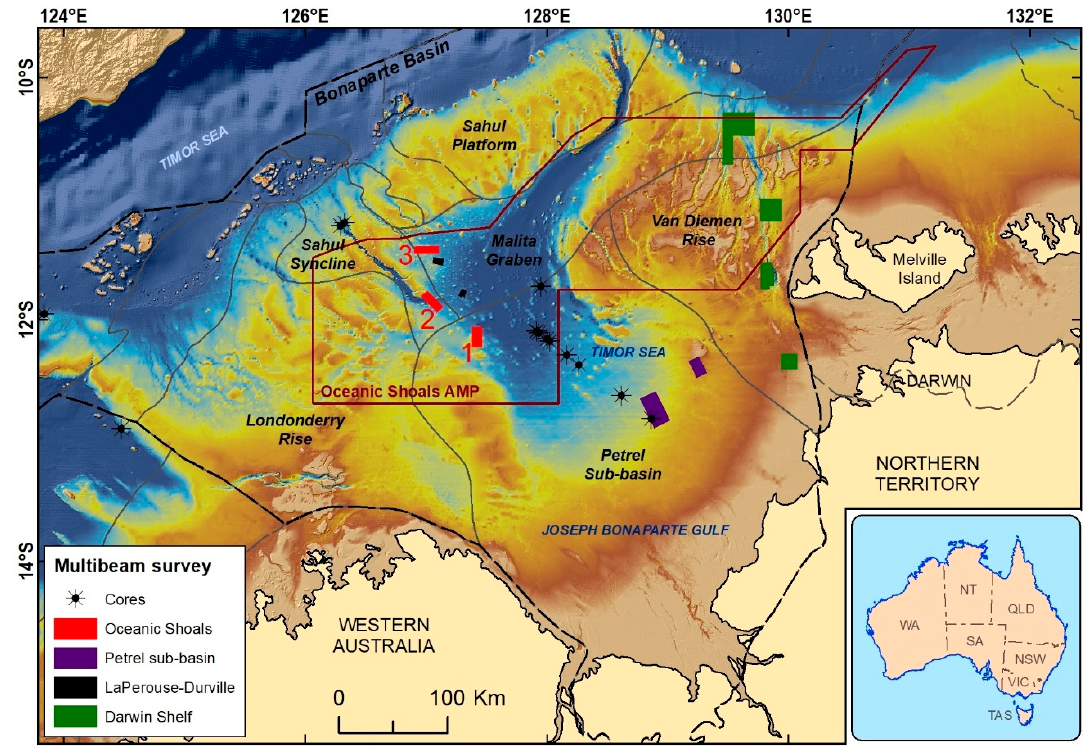
Fig.1 Figure 1. Location map showing the study area (Oceanic Shoals survey) within the Oceanic Shoals Australian Marine Park (brown outline) in the Timor Sea, Northern Australia. Geological setting is also included with the encompassing Bonaparte Basin as a bold dashed line and its subdivisions as continuous line. Post-survey reports that are associated with the survey outlined in this figure are as followed: Oceanic Shoals [21], Petrel Sub-basin [29], LaPerouse-Durville [29], Darwin Shelf [24,25], cores [27]. Figure modified from